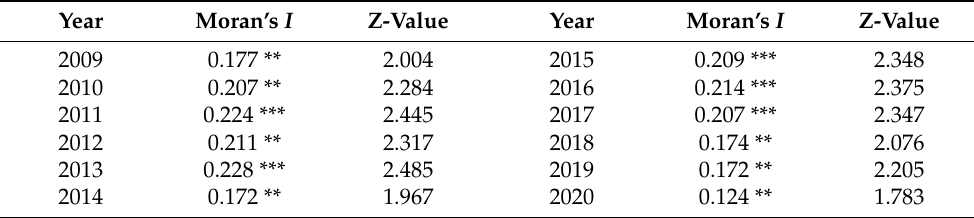
Table 6. The Global Moran’s I of